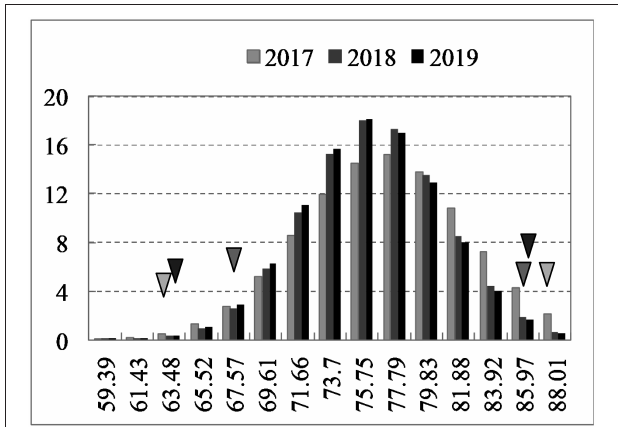
FIGURE 2 | Frequency distributions of seed oleic acid content from 2017 to 2019. Triangles on the left and right of the figure represent the low oleic acid content line “E183” and high oleic acid content line “FC81”,